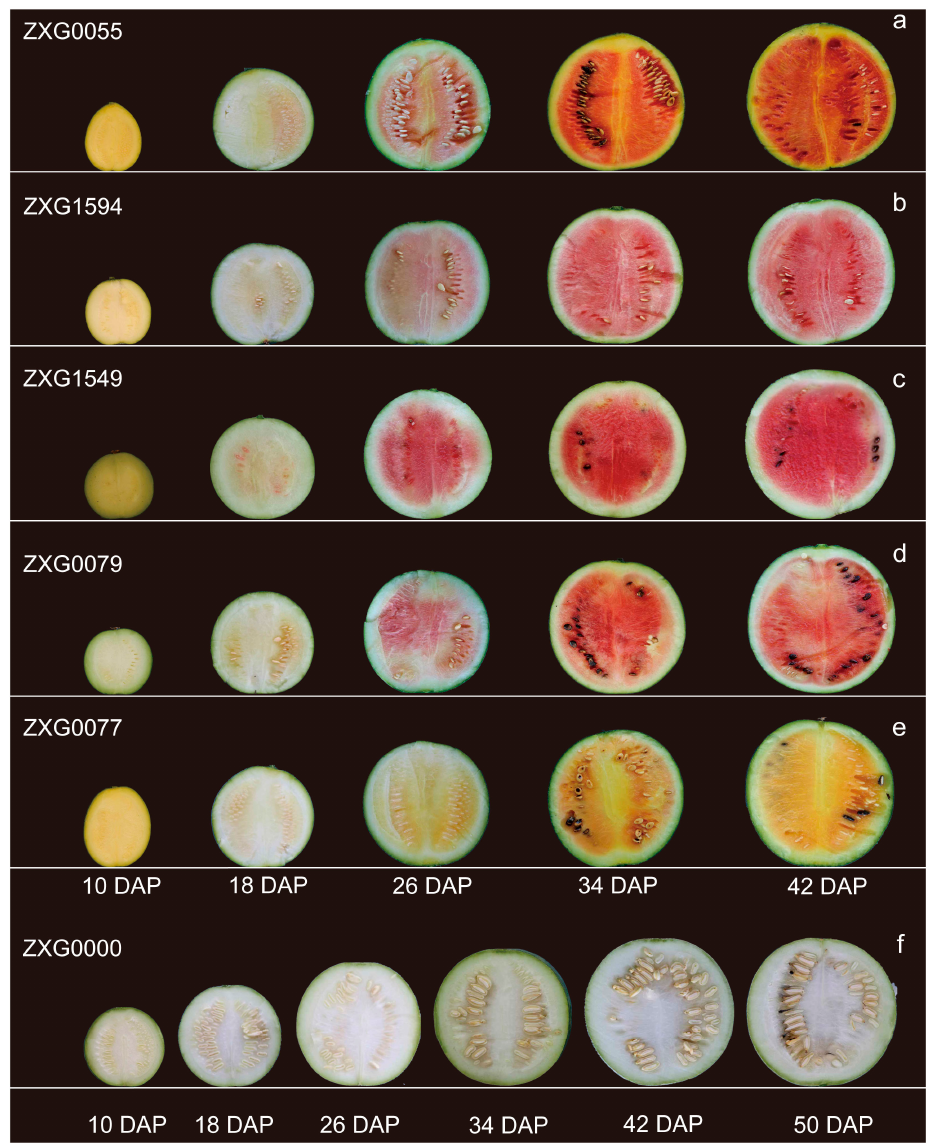
Figure 2. Photographs of six watermelon accessions with different flesh colors at five or six time points (10, 18, 26, 34 and 42 or 50 days after pollination) during fruit development. ( a – f ): ‘ZXG0055’, ’ZXG1594’, ’ZXG1549’, ’ZXG0079’, ‘ZXG0077’and ‘ZXG0000’,respectively.